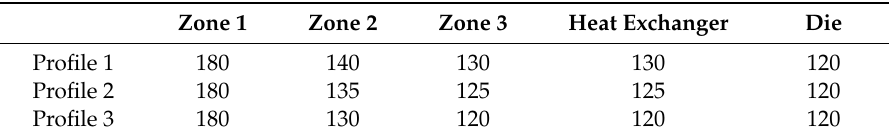
Table 4. Various temperature profiles during extrusion foaming in the second cooling extruder of the tandem-screw extruder. Reprinted from Keshtkar et al. [151]. Copyright (2020), with permission from Elsevier.